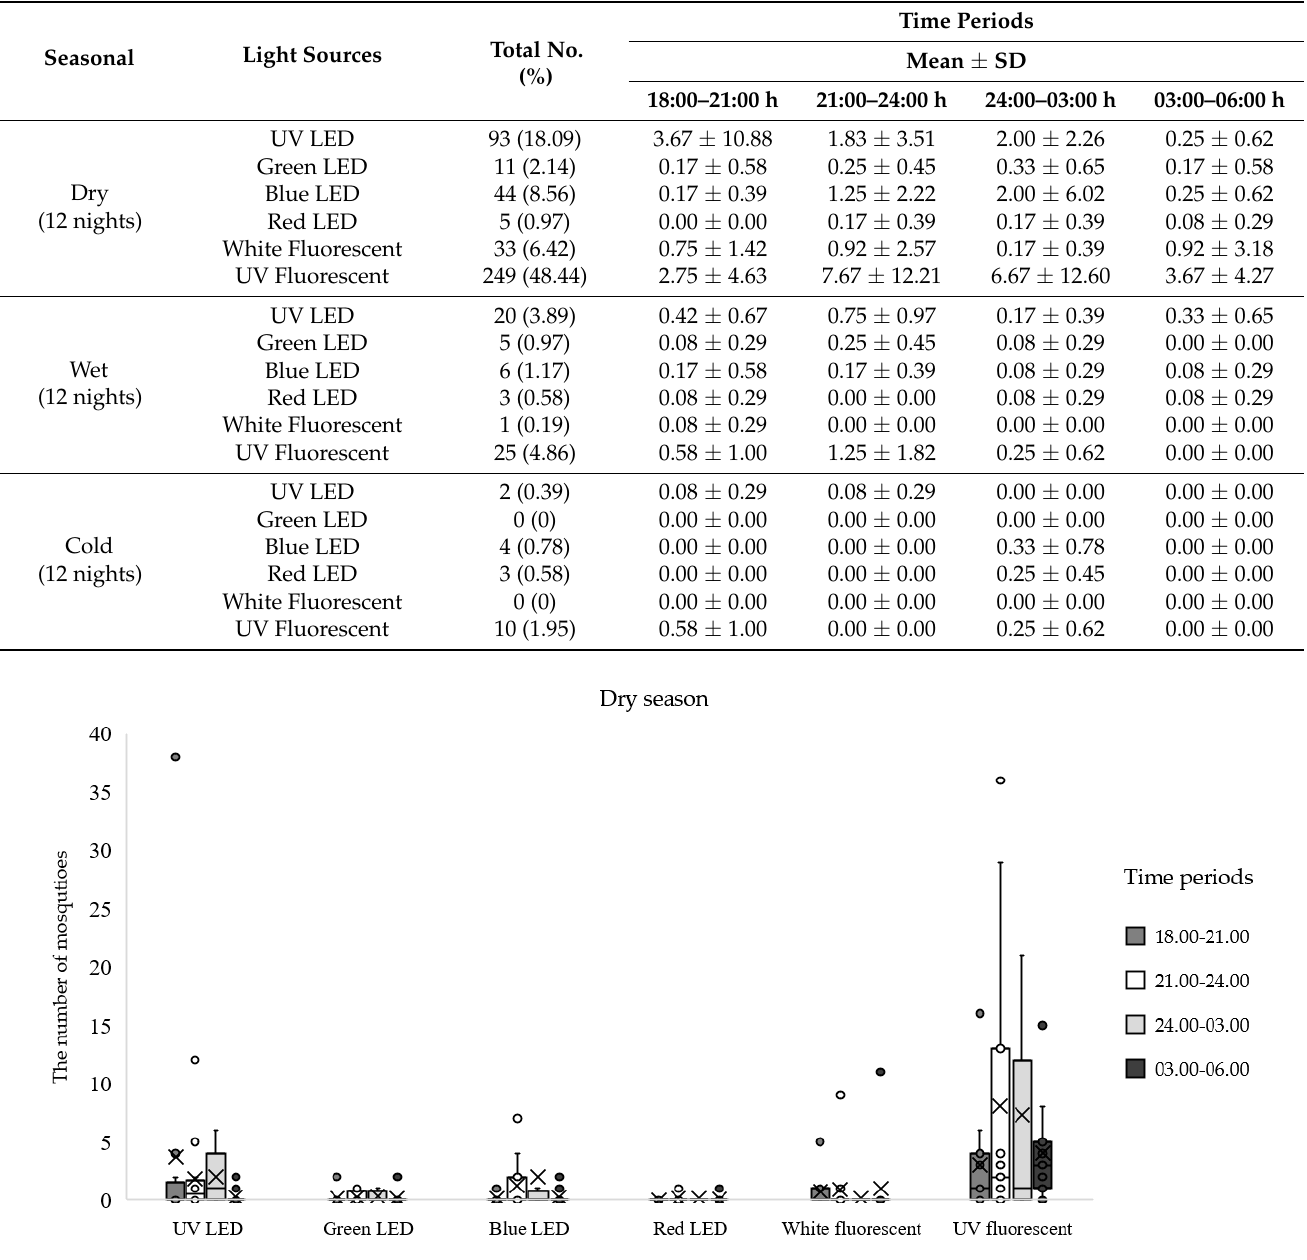
Table 4. Mean number ( ± SD) of Anopheles mosquitoes collected at different times of the night over three seasons, using six different light-source traps.